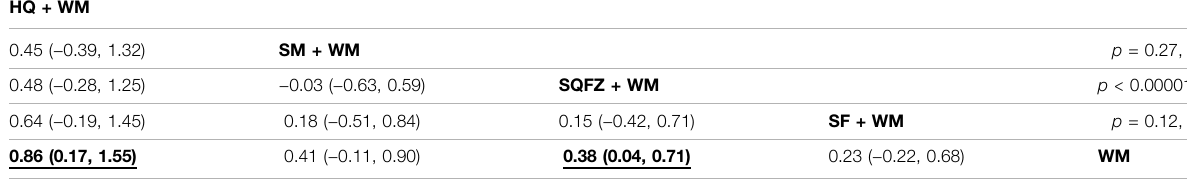
TABLE 11 | SUCRA results of the outcomes. APACHE II score (%)